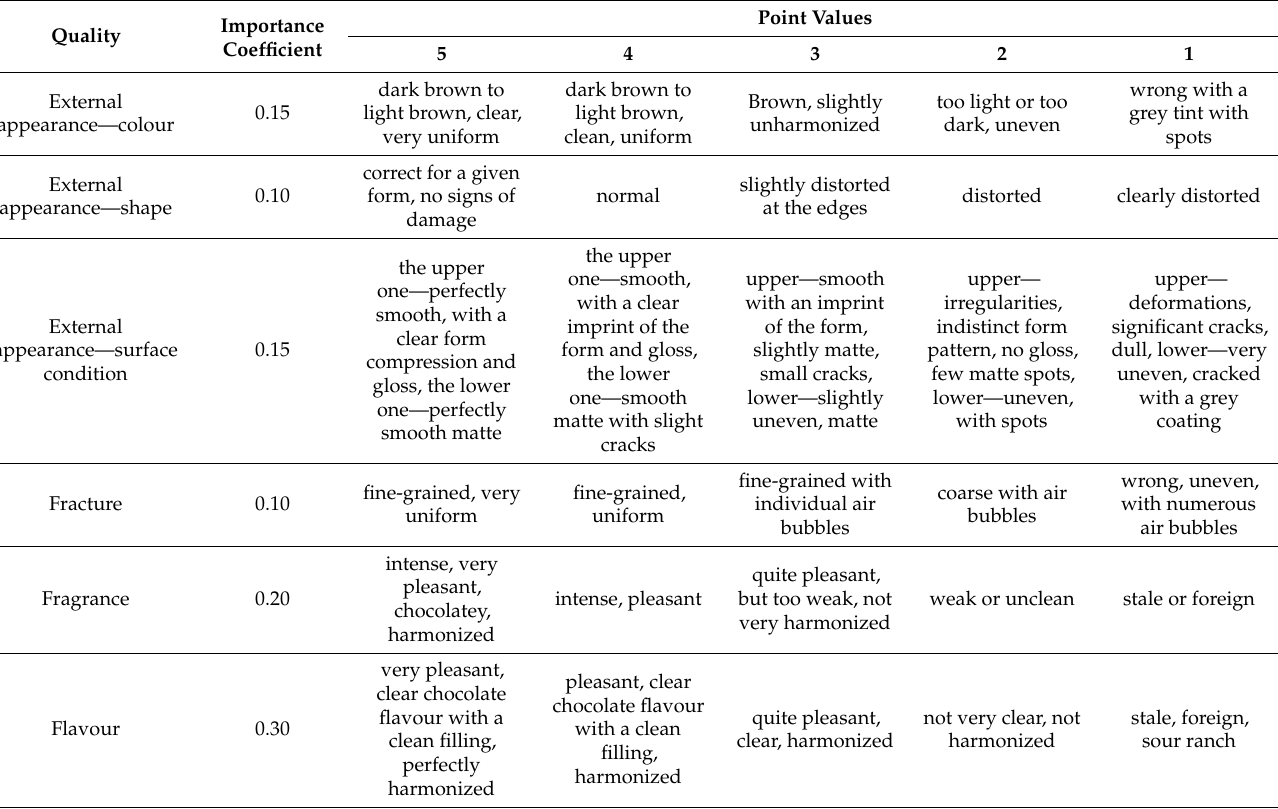
Table 1. Definitions of product quality for the five-point sensory